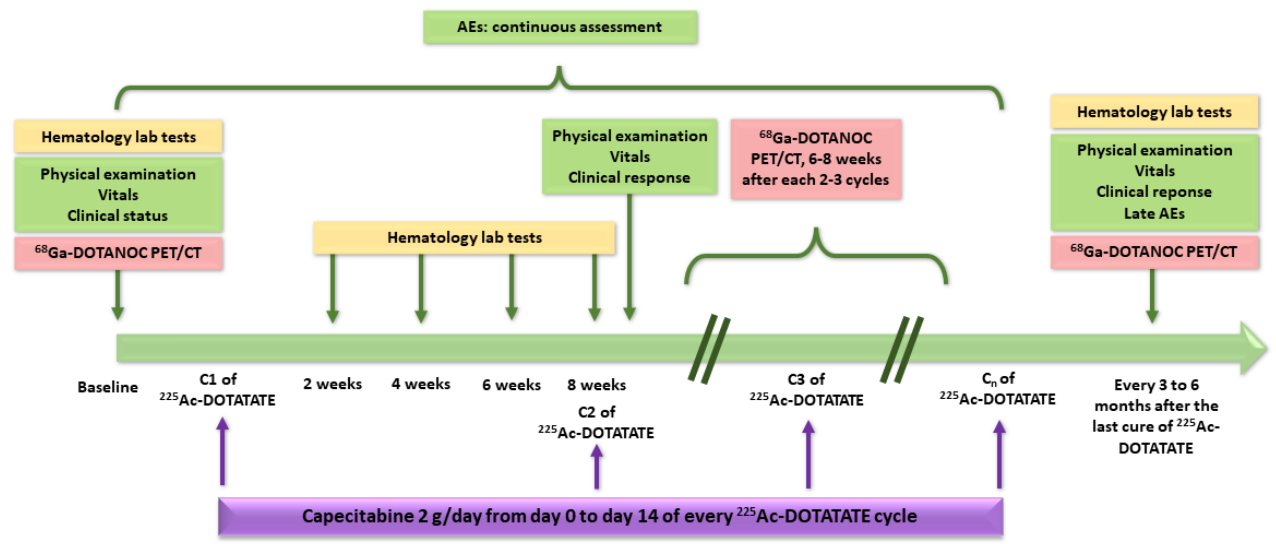
Figure 10. Design of the study reported by Ballal et al. [212]. Clinical status and clinical response were assessed with Karnofsky performance status and Eastern Cooperative Oncology Group (ECOG) performance status. AEs: adverse events.